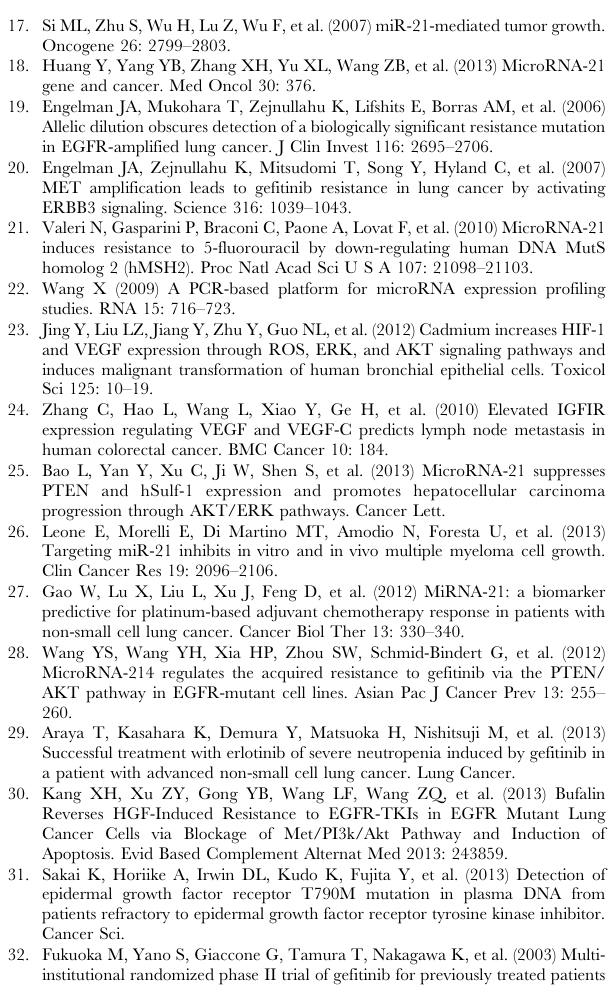
Figure S2 Pten protein levels in xenograft tumors analyzed by IHC. Table S1 Clinicopathological data for the 47 NSCLC samples. Table S2 Clinical, pathologic, category of TKI and response to TKI therapy in the 46 studied